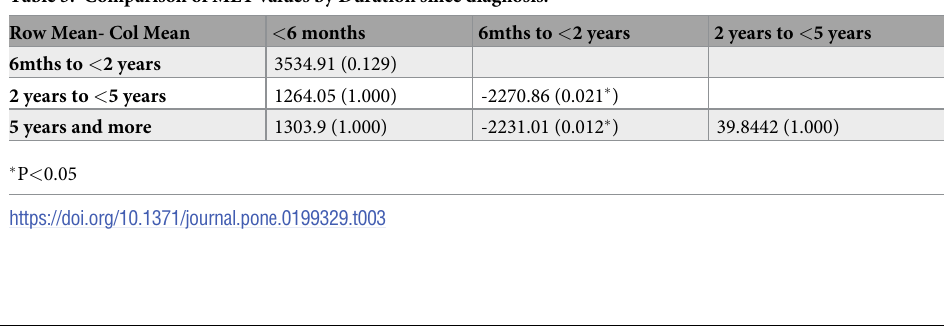
Table 3. Comparison of MET values by Duration since